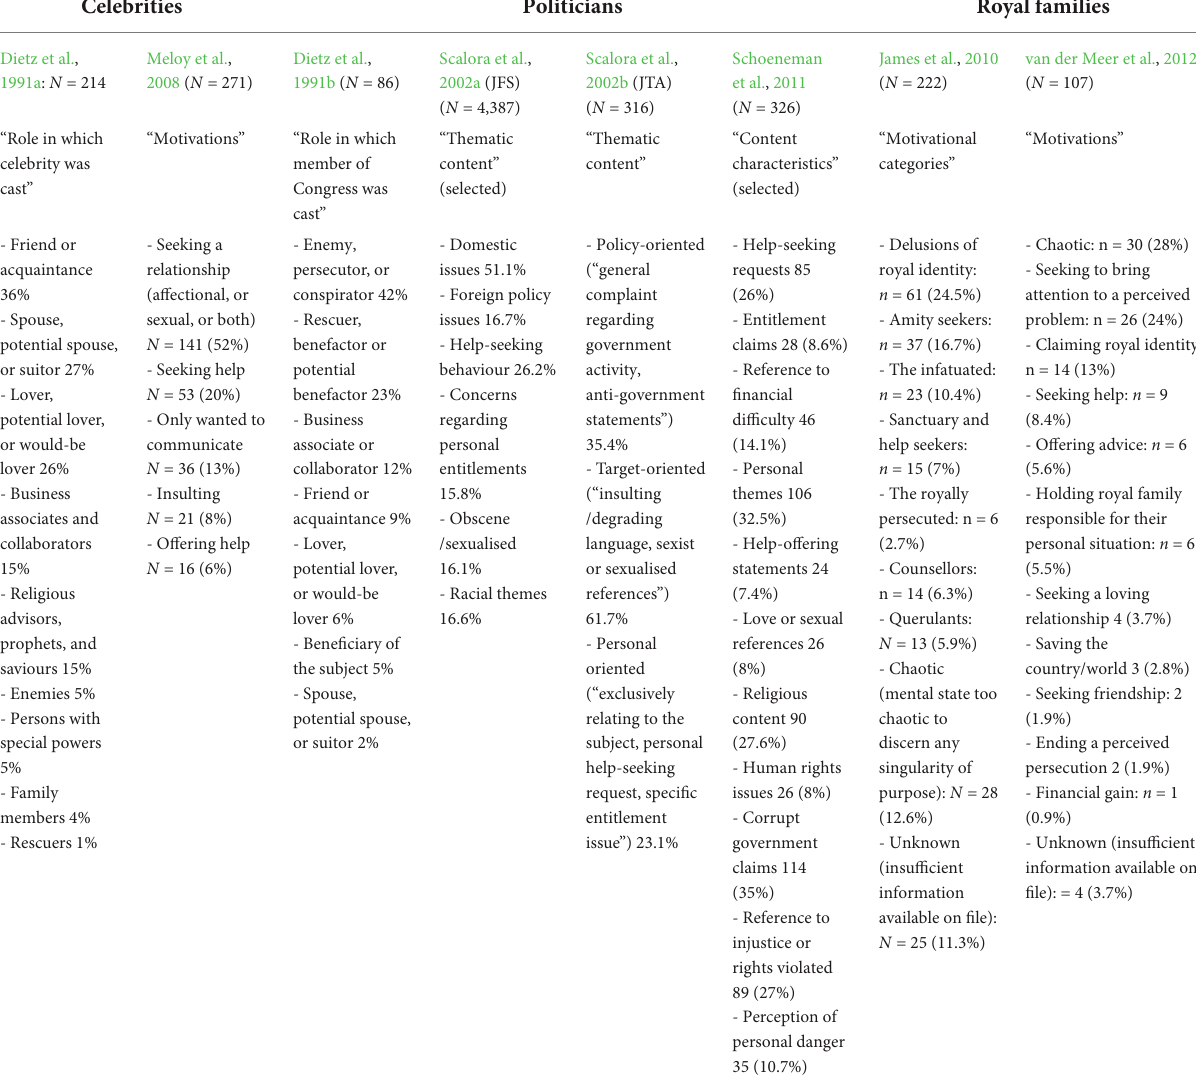
TABLE 1 Motivational categories adopted in eight studies which examined associations between threats and approach.